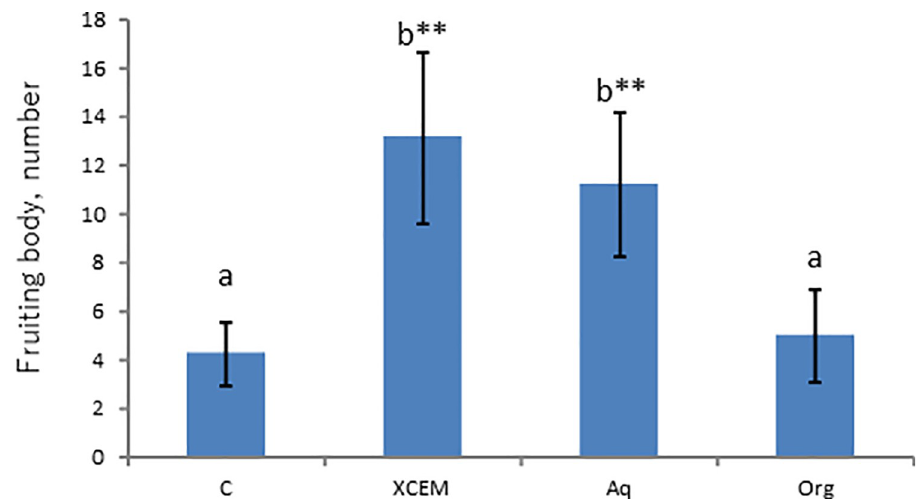
Fig 1. Liquid-liquid partition of EMF activity. The activity was recovered in aqueous phase. C (Control without ECEM); ECEM (10% ECEM); Aq (Aqueous phase); Org (Organic phase). �� : Significant difference in comparison to the Control by Steel test (p < 0.01), a,b: different letters show significant difference by Steel-Dwass test(p < 0.01).